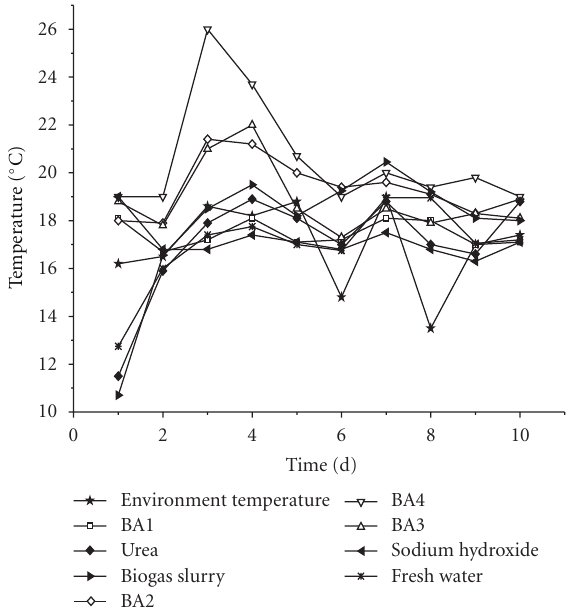
Figure 2: Changes in the temperature during the pretreatment process.